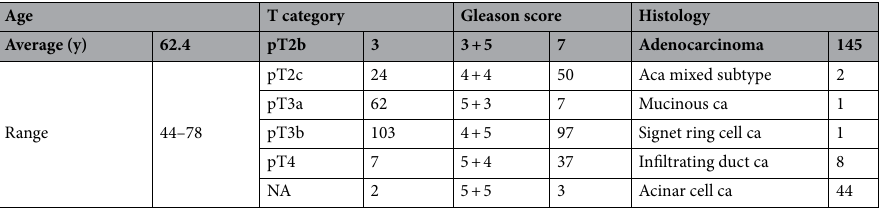
Table 1. Baseline characteristics of patients in the TCGA database (Gleason score ≥ 8). The numbers to the right of each column denote the number of patients. pT: pathological T; NA: not applicable; Adenocarcinoma: Adenocarcinoma NOS; Aca: Adenocarcinoma; Ca: